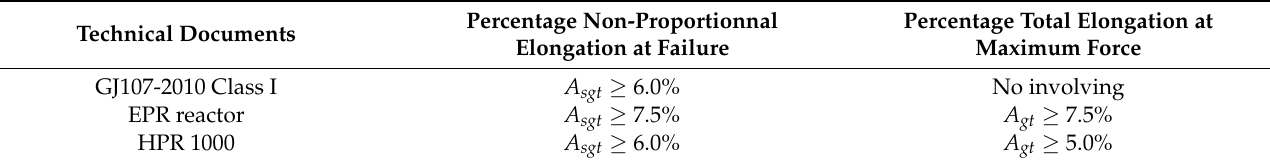
Table 5. Technical requirements comparison.